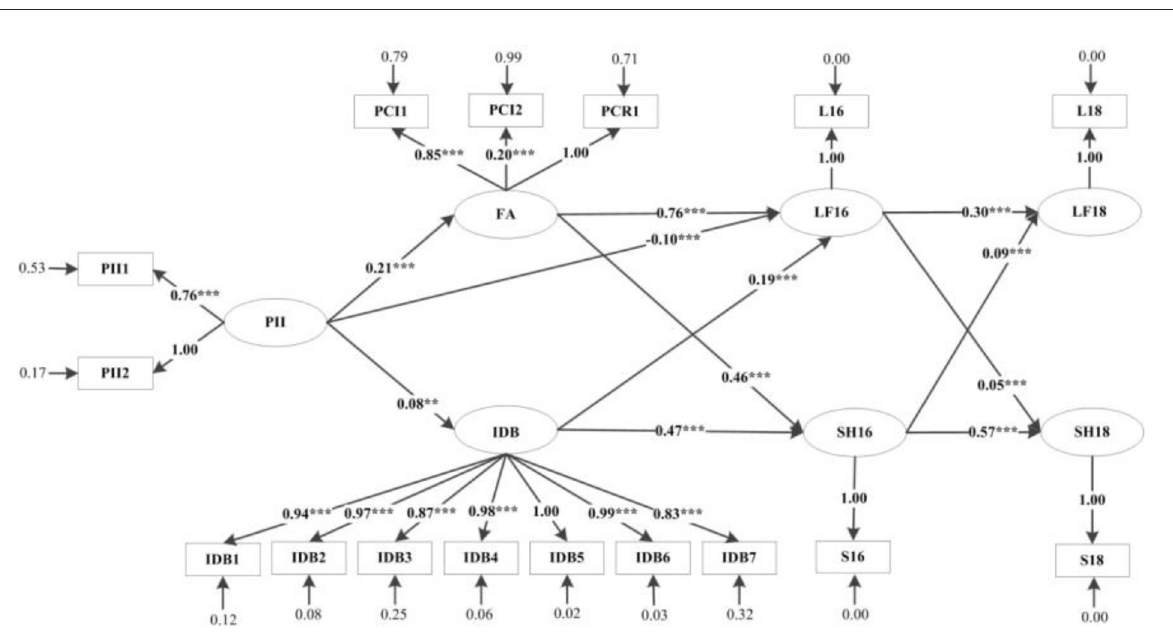
FIGURE3 Structural equation modeling results. PII, perceived importance of the Internet; FA, family atmosphere; IDB, independent behavior; LF16, life satisfaction in 2015–2016; SH16, self-rated health in 2015–2016; LF18, life satisfaction in 2017–2018; SH18, self-rated health in 2017–2018; ** p < 0.01, *** p <